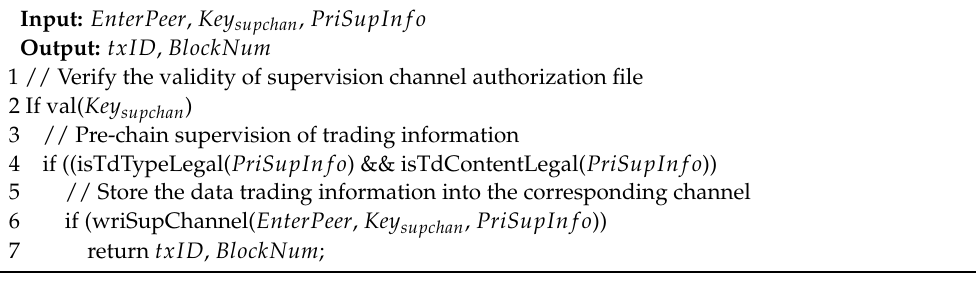
Algorithm 1 : Smart contract for private supervision information on-chain